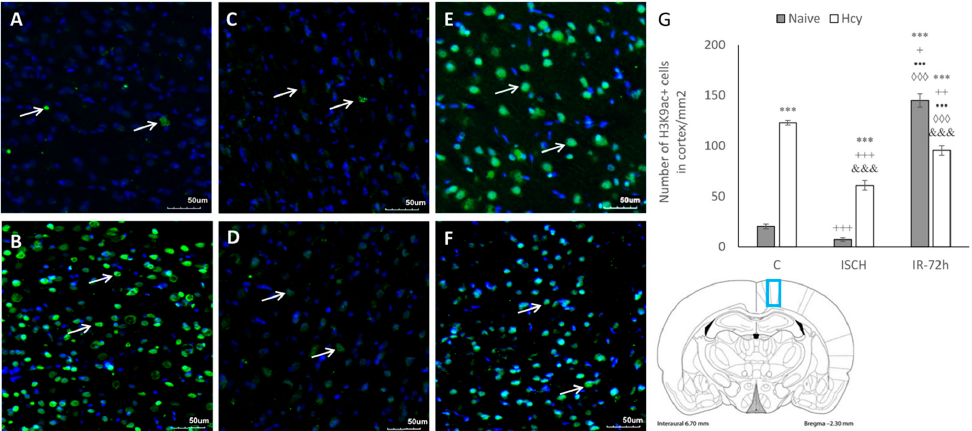
Figure 2. Fluorescence micrographs and statistical evaluation of H3K9ac positive (+) neurons in the M1 area (blue rectangle on the schematic coronal section) of rat brain cortex. Micrographs of naive control ( A ), Hcy-C ( B ), naive ischemic groups (ISCH) ( C ), Hcy-ISCH ( D ), naive IR-72h ( E ) and Hcy-IR-72h ( F ). Arrows indicate H3K9ac+ neuronal nuclei (green) in the M1 area of rat brain. Nuclei are co-stained with 4 (cid:48) ,6-diamidino-2-phenylindole (DAPI) (blue). Bar = 50 µ m, n = 5/group. ( G ) Number of H3K9ac+ nuclei in the M1 area in naive control, Hcy-C, naive ISCH, Hcy-ISCH, naive IR-72h and Hcy-IR-72h. Results are presented as mean ± SEM, n = 5/group. *** p < 0.001 versus the control value; + p < 0.05, ++ p < 0.01 and +++ p < 0.001 versus the control with Hcy; ••• p < 0.001 versus the naive ♦♦♦ p ISCH group; < 0.001 versus the ISCH with Hcy; and &&& p < 0.001 versus the corresponding reperfusion